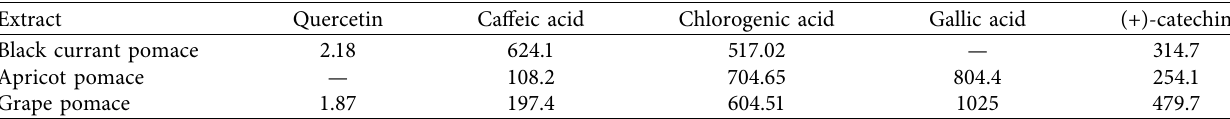
Table 5: Concentration of predominant compounds ( μ